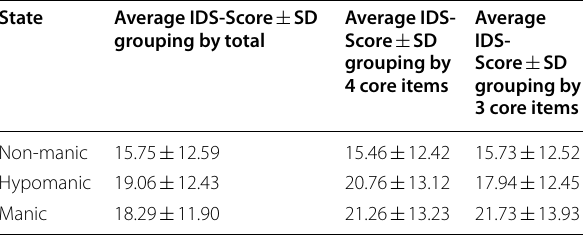
Table 2 Mean IDS-C scores for the YMRS-groups (total and core items) EVEN SAMPLE